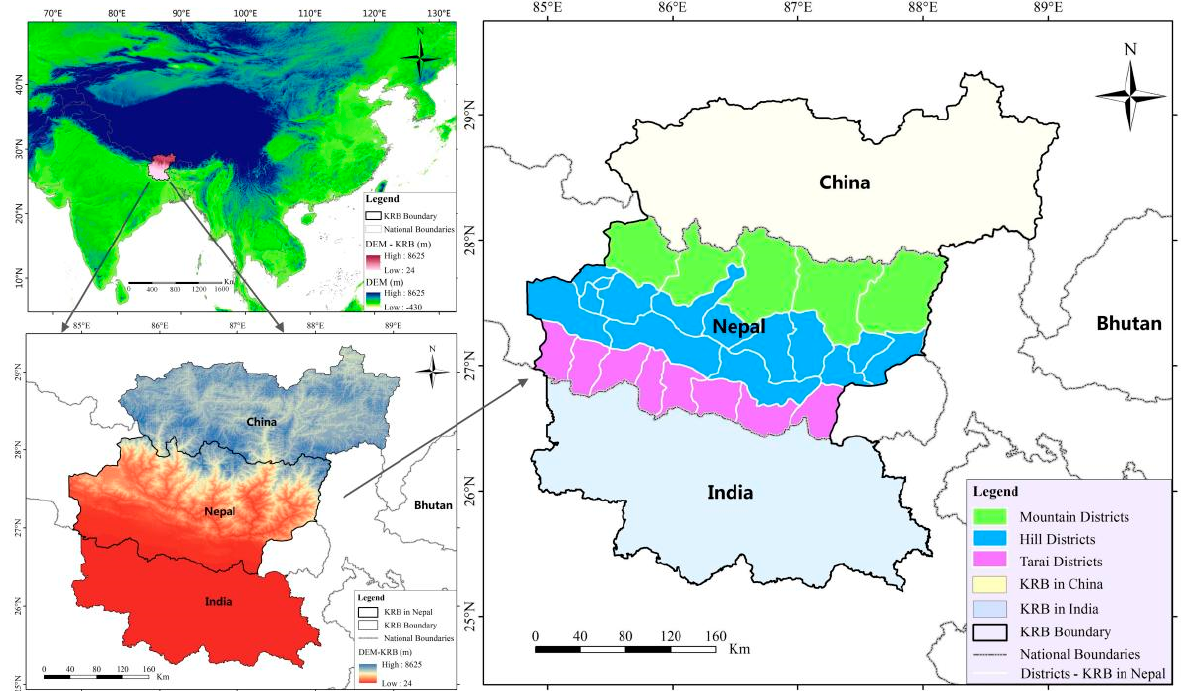
Figure 1. Location of the Koshi River basin.